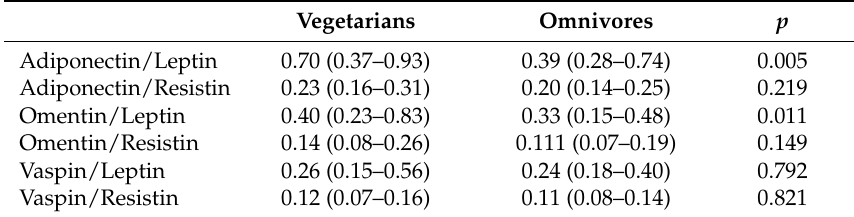
Table 4. Ratios of anti-inflammatory adipokines (adiponectin, omentin, vaspin) to pro-inflammatory adipokines (leptin, resistin) in children on vegetarian and omnivorous